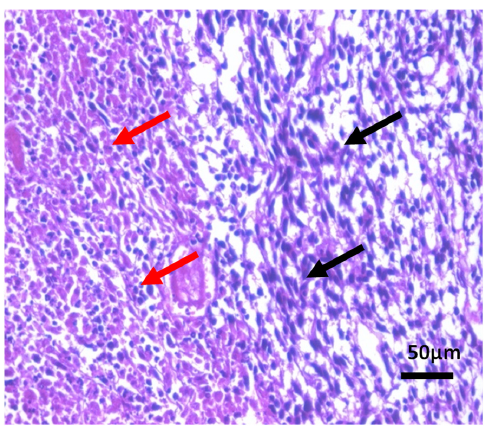
Figure 14. Sections treated with P. roxburghii extract showed a scattered sheet of dysplastic epithelial cells with rounded nuclei with an increased nucleocytoplasmic ratio ( black arrow ), with many apoptotic cells and necrosis ( red arrows ) (HE, ×